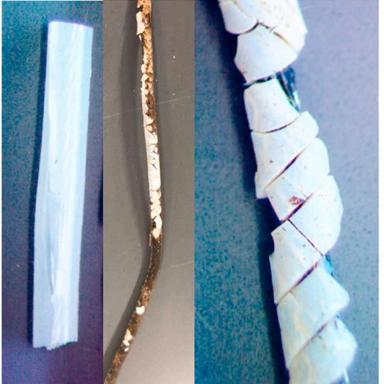
Baseline (left) and vacuum (middle and right) silicone rubber insulations.